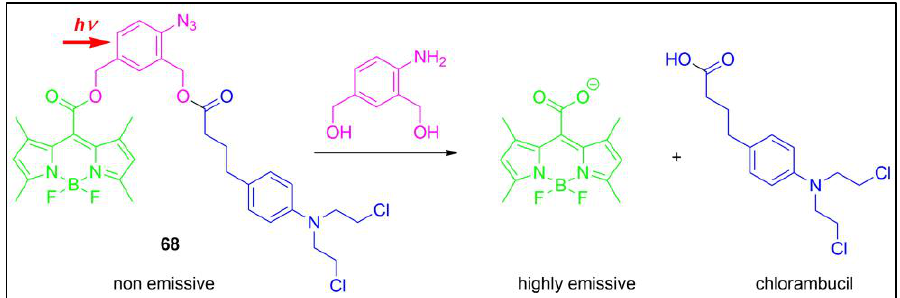
Figure 64. Structure of 68 and release process of drug molecule and fluorescent dye upon light activation [174].